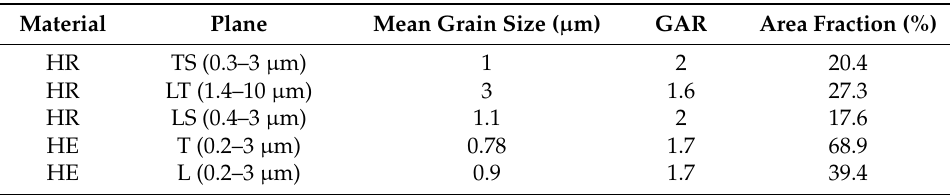
Figure 5. Inverse pole figures of ( a ) LT plane in ODS-KIT HR and ( b ) longitudinal plane (L) in ODS-KIT HE. Table 1. Grain size analysis for fine grains in ODS-KIT (from [17,18]).